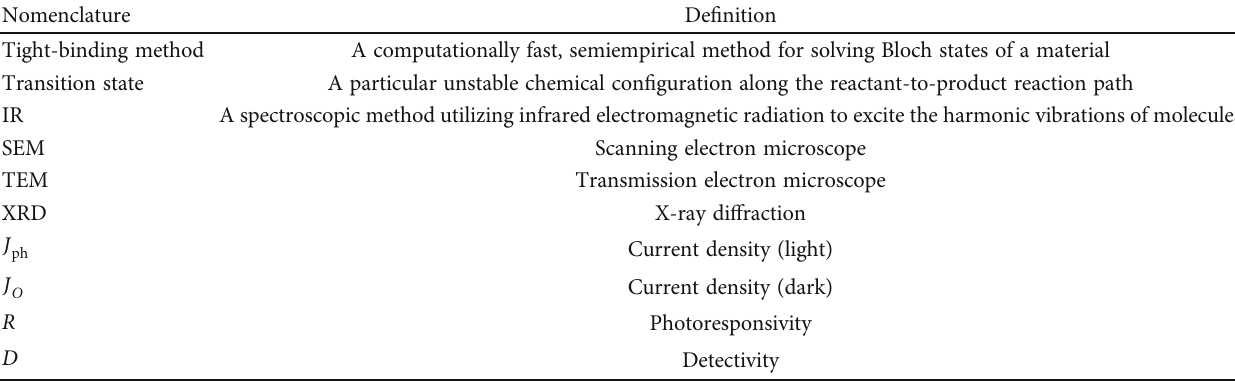
Table 4: The nomenclature and its de fi nition of the items used in the present theoretical and experimental study.